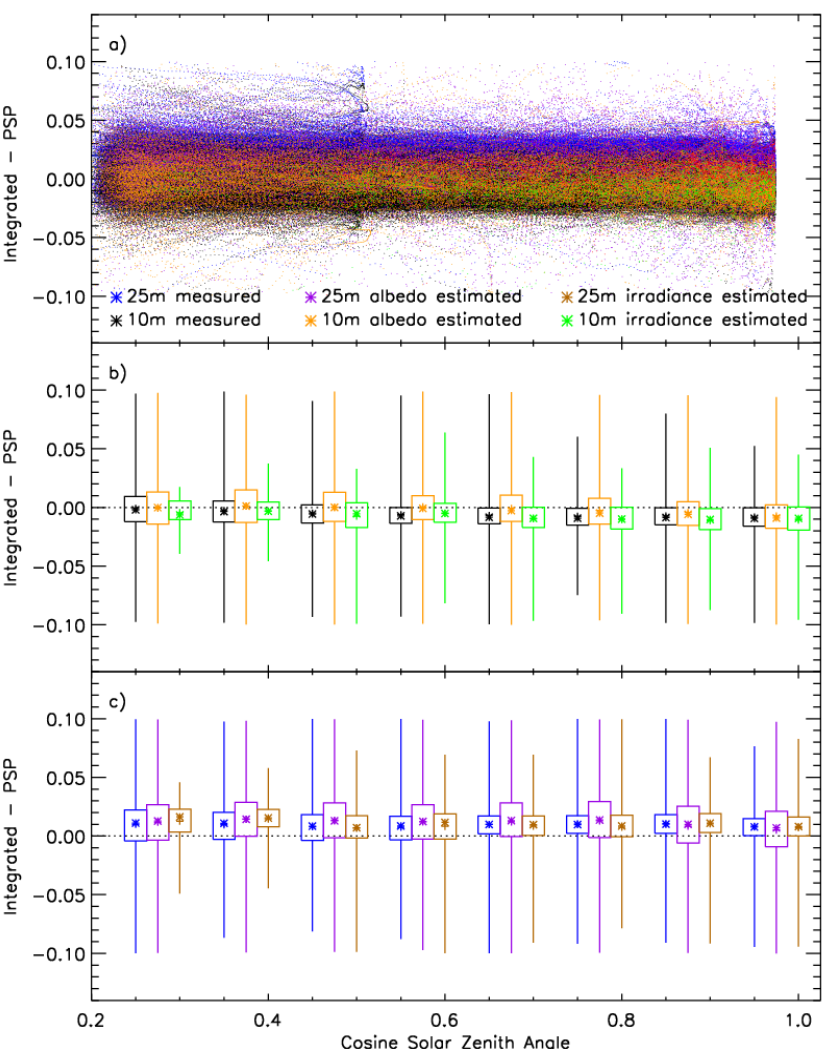
Fig. 11. As in Fig. 10, but residuals are plotted as a function of the cosine of the solar zenith angle. each surface type given the input MFR narrowband